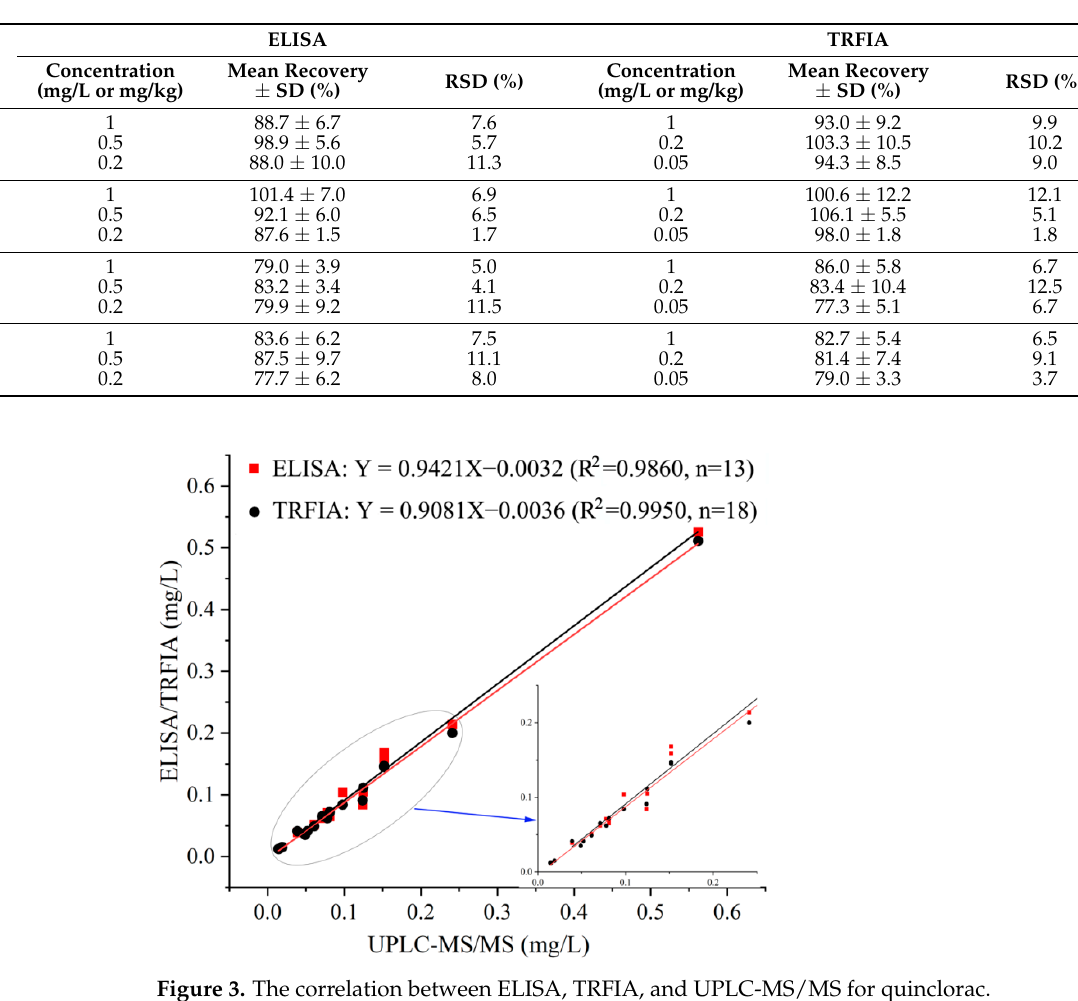
Table 2. The recoveries of quinclorac in spiked samples ( n = 3).